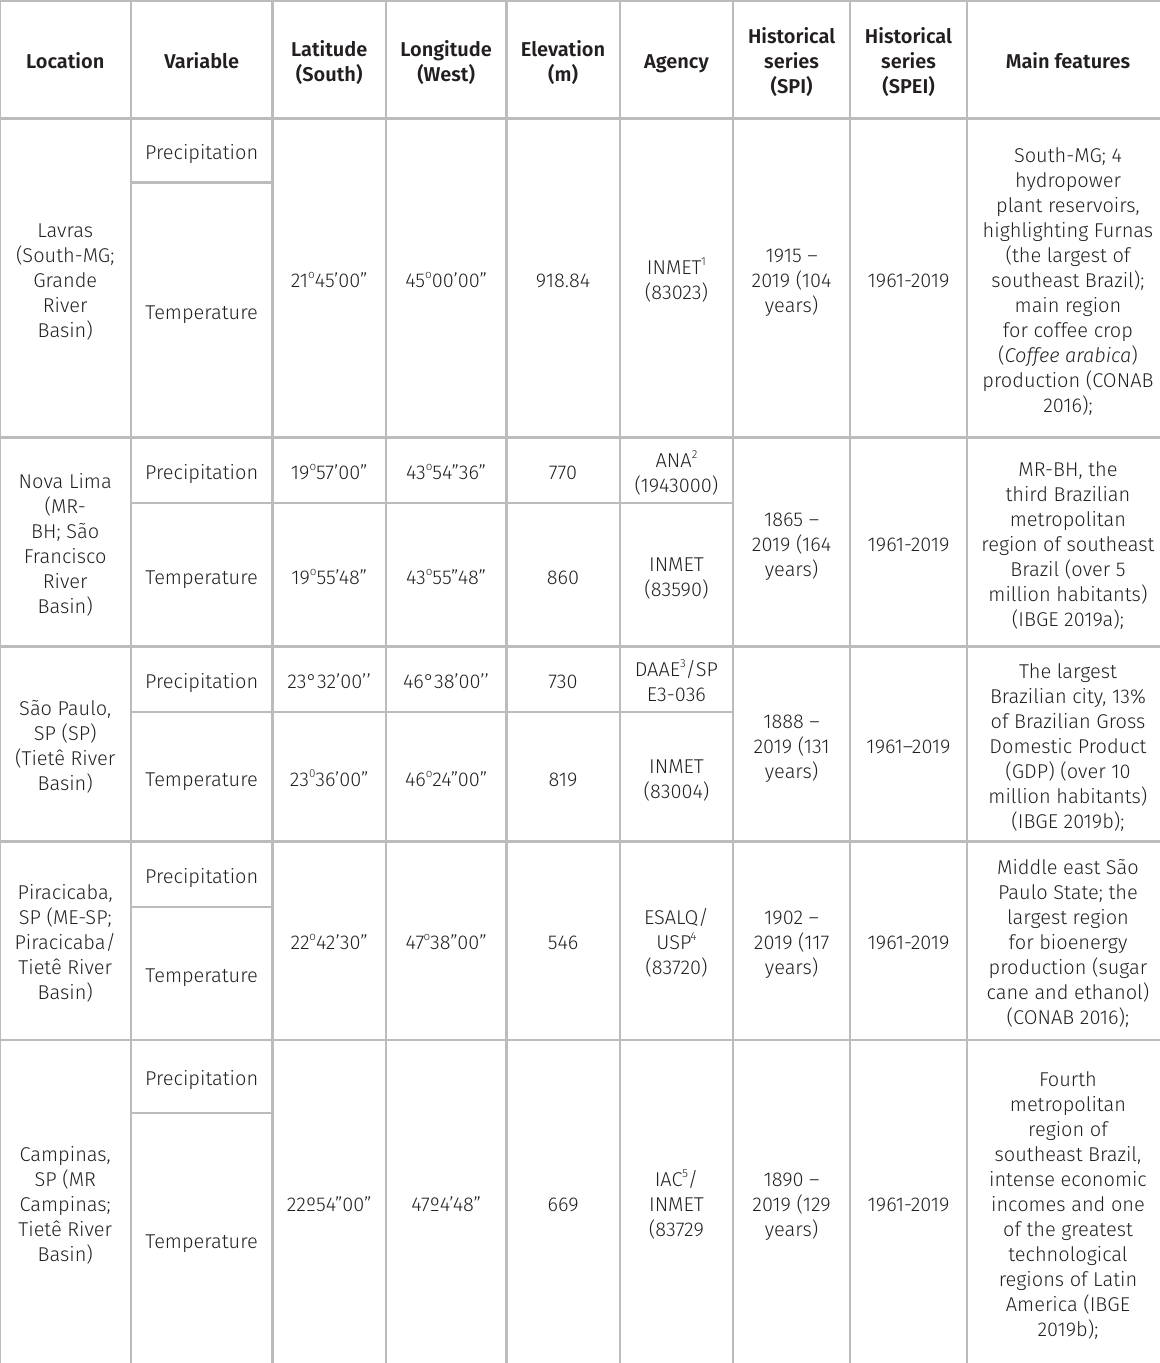
Table I. Characteristics of the meteorological stations used in this study and the main features of the each region.